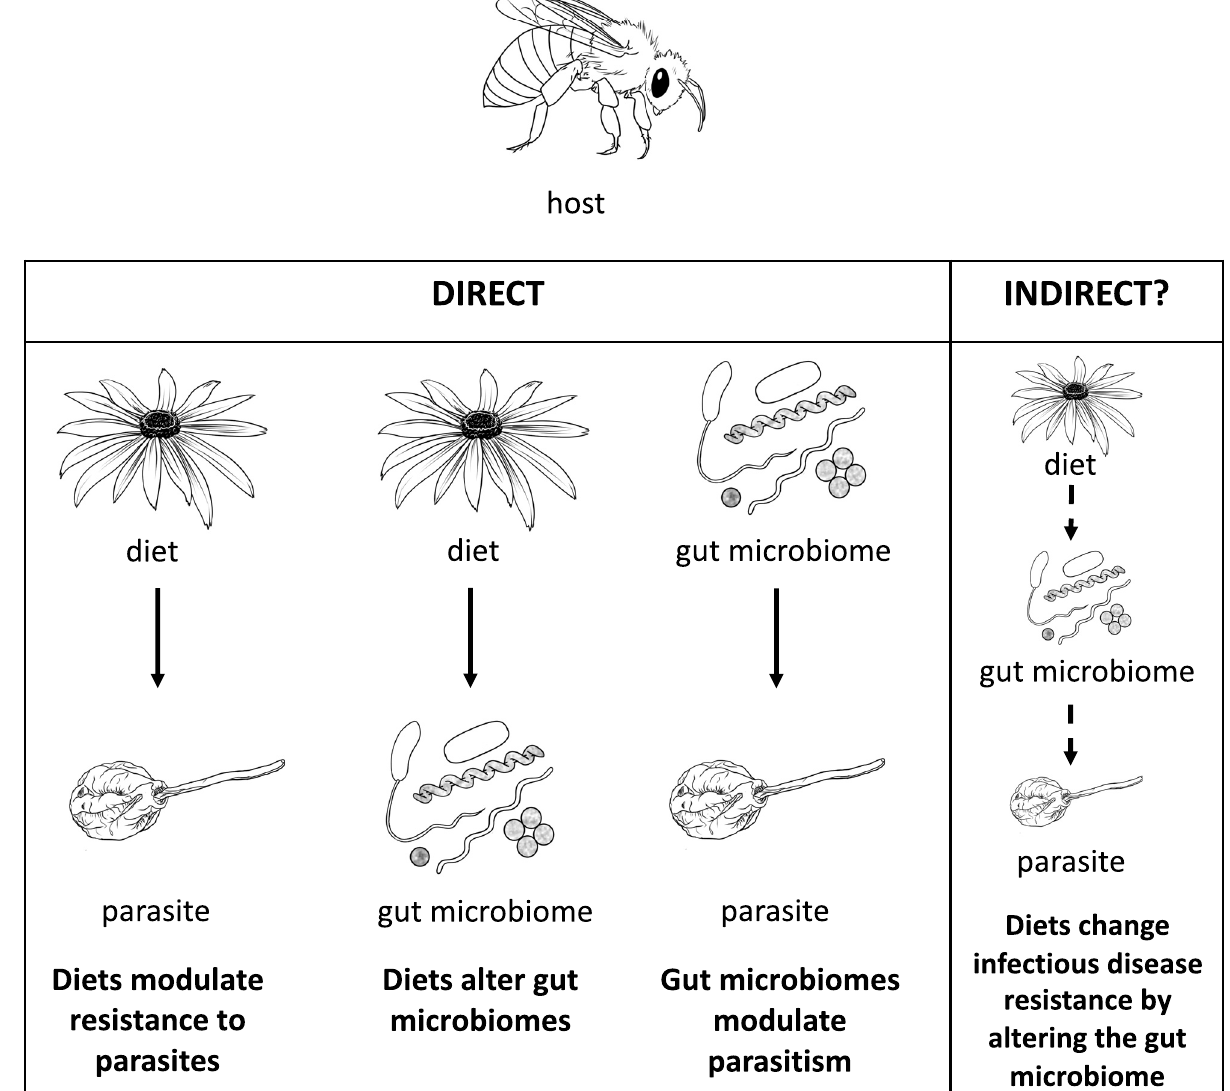
Fig 1. Direct and indirect relationships between host diet, host gut microbiome, and parasites. In bees, studies have independently shown that diets modulate resistance to parasites [9,21], diets alter gut microbiomes [75], and gut microbiomes modulate parasitism [90,107].However, it is not known whether there is an indirect link between the three based on these direct relationships. Alternatively, the host immune system can indirectly alter this potential three-way interaction by modulating antimicrobial peptides or pattern recognition receptors via diet or the gut microbiome to fight parasites